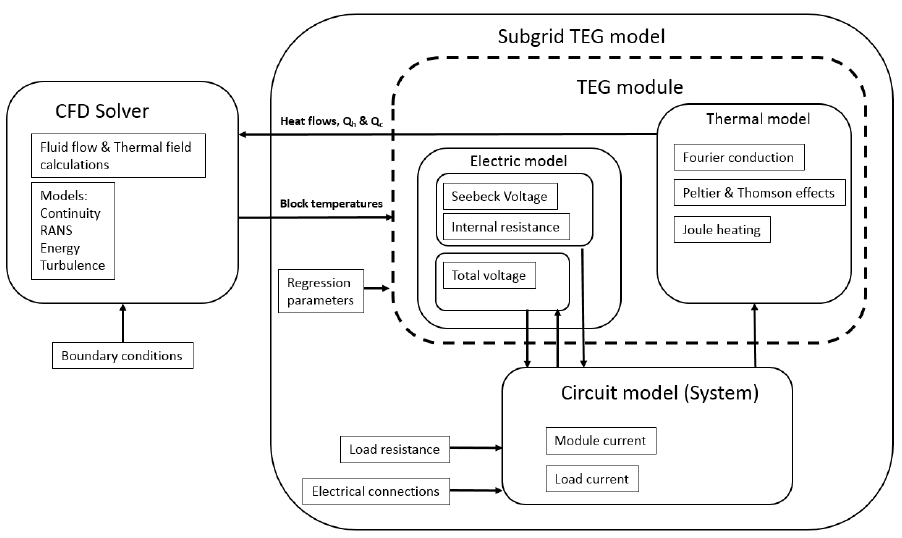
Figure 3. Schematic of program structure and calculation procedure.